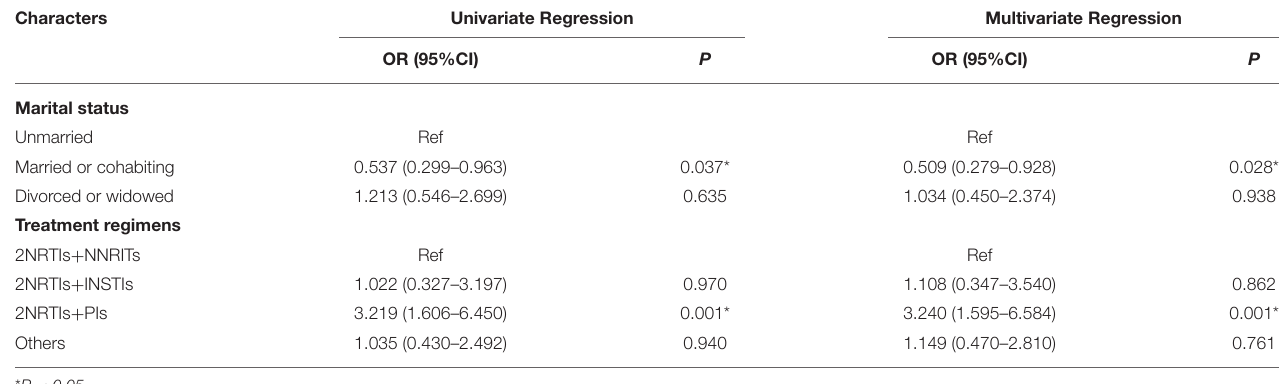
TABLE 3 | Factors associated with drug resistance among LLV patients.